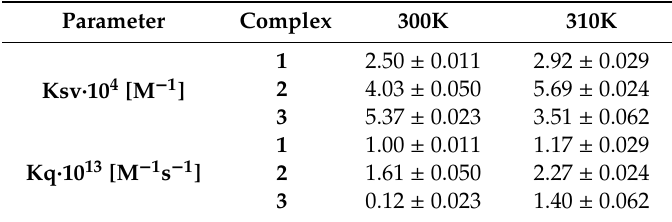
Table 3. The quenching parameters of the apo-Tf – Cu